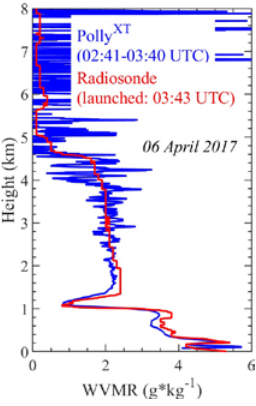
Figure 4. Comparison of water vapor mixing ratio profile with Polly XT and radiosonde.